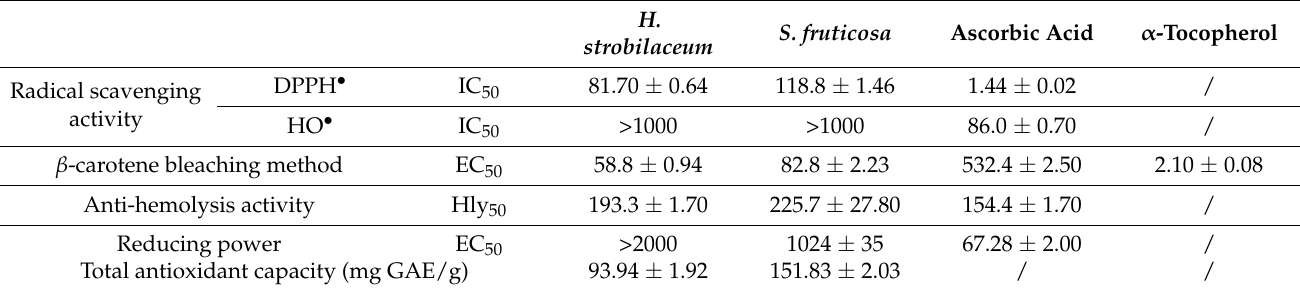
Table 6. IC 50 , EC 50 , or Hly 50 values ( µ g/mL) for methods of evaluating antioxidant activity. H.